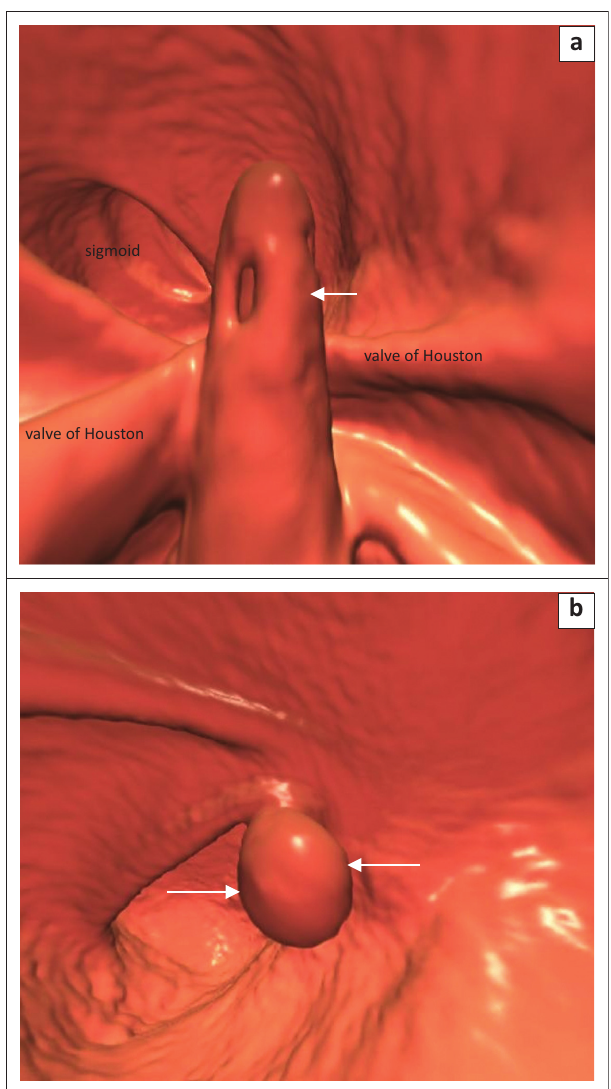
FIGURE 4: (a) 3D image shows the tip of catheter (white arrow) extending beyond the superior valve of Houston; (b) 3D image shows tip of catheter projecting beyond the superior valve of Houston causing simulation of polyp appearance (white arrows).